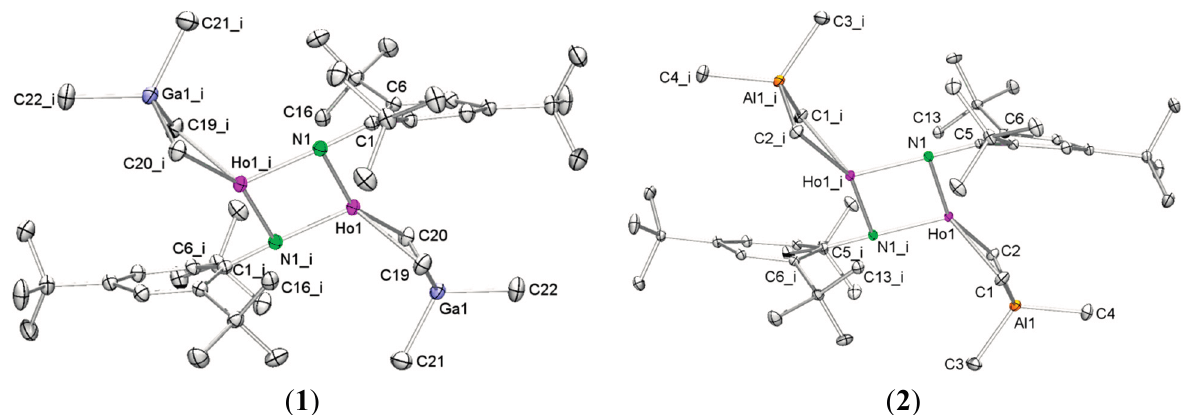
Figure 2. Solid-state structures of [Ho{Al(CH 3 ) 4 }(µ 2 -Nmes*)] 2 ( 1 ) and [Ho{Ga(CH 3 ) 4 } (µ 2 -Nmes*)] 2 ( 2 ) with 30% probability ellipsoids. Hydrogen atoms are omitted for